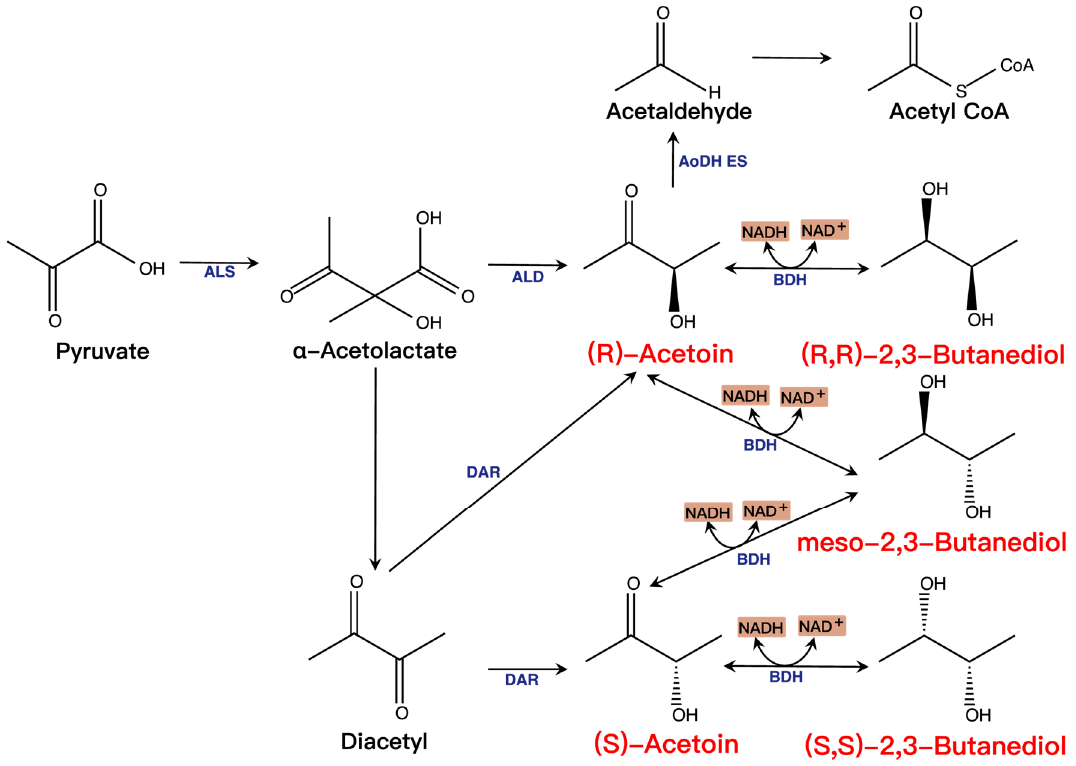
Figure 3. Synthesis and metabolism of acetoin and 2,3-BD. The essential microbial metabolic pathways, enzymes, and cofactors (e.g., NAD + and NADH) are involved in acetoin and 2,3-BD formation and consumption.